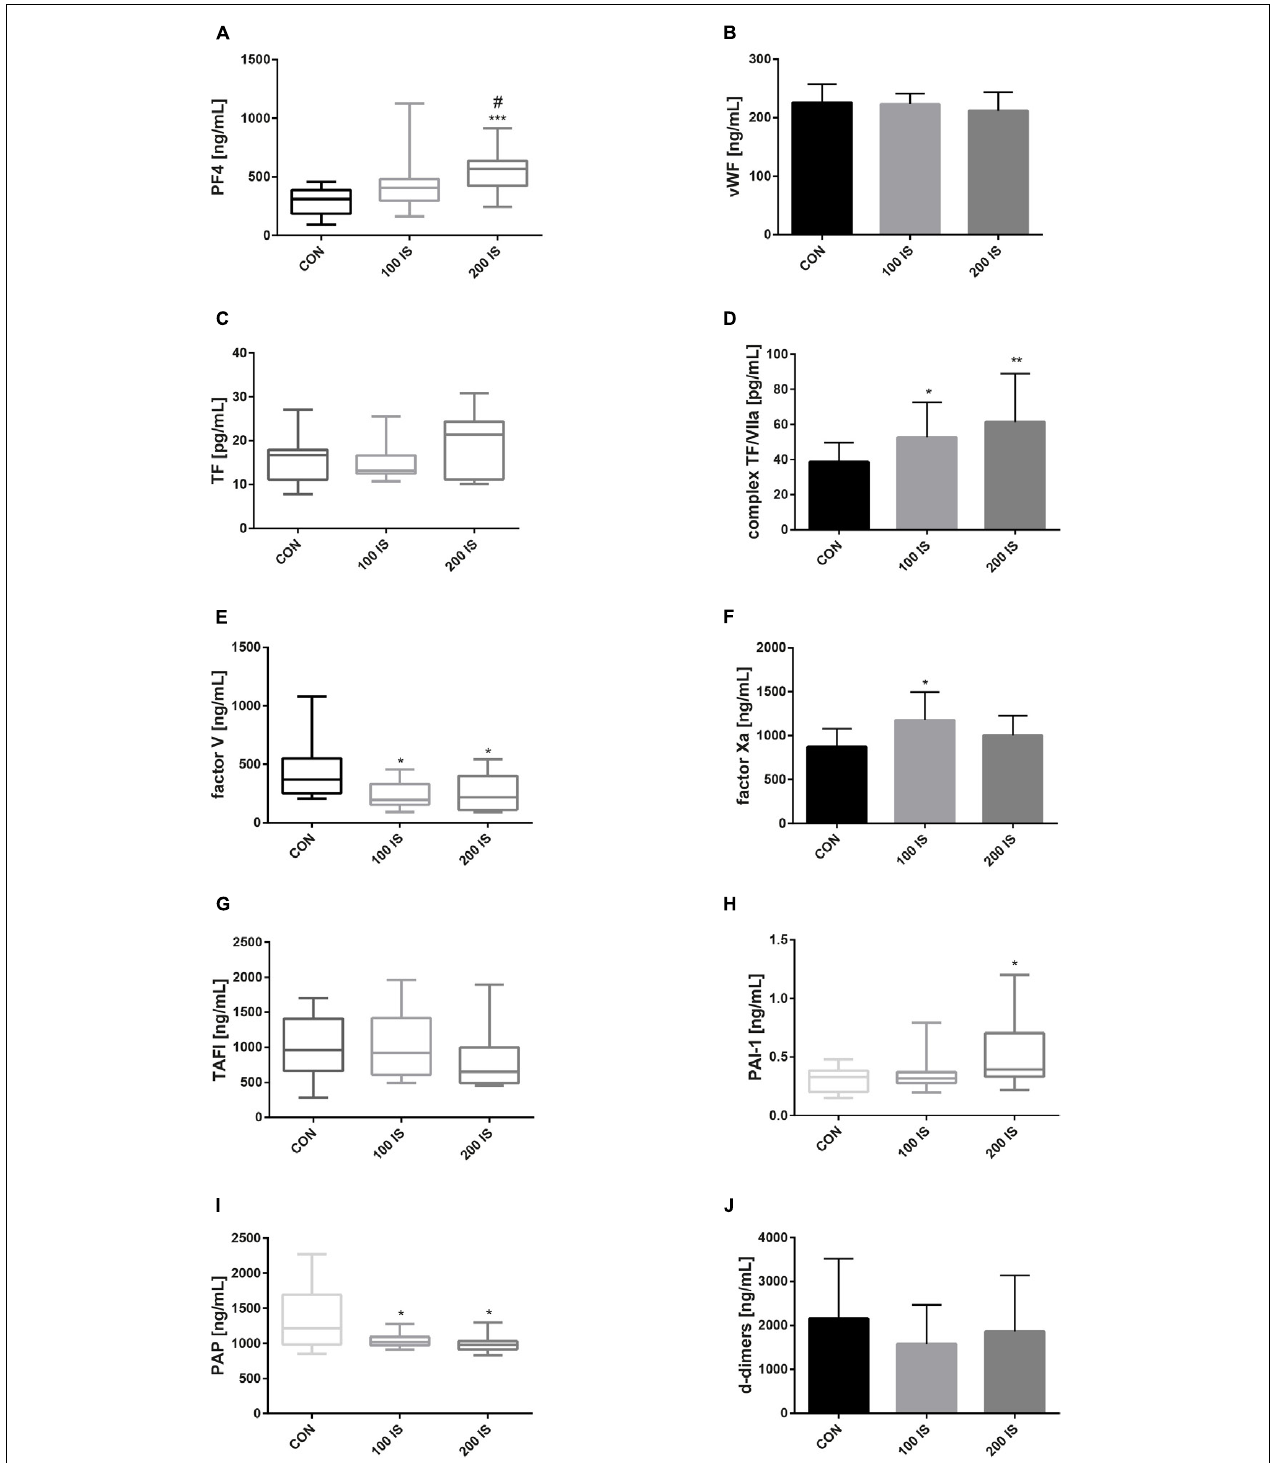
FIGURE 4 | IS-induced changes in hemostatic parameters: PF4 (A) , vWF (B) , TF (C) , TF/VII complex (D) , FV (E) , FXa (F) , TAFI (G) , PAI-1 (H) , PAP (I) , and d-dimers (J) . Data are presented as the mean ± SD or median (full range) depending on their distribution. CON, control group; 100 IS, group receiving IS in the dose of 100 mg/kg b.w./day; 200 IS, group receiving IS in the dose of 200 mg/kg b.w./day; IS, indoxyl sulfate; PF4, platelet factor 4; vWF, von Willebrand factor; FV, coagulation factor V; FXa, activated coagulation factor X; TF, tissue factor; TF/VII complex, TF/coagulation factor VII complex; TAFI, thrombin activatable fibrinolysis inhibitor; PAI-1, plasminogen activator inhibitor-1; PAP, plasmin-alpha2-antiplasmin complex; ∗ p < 0.05 compared to control; ∗∗ p < 0.01 compared to control; ∗∗∗ p < 0.001 compared to control; # p < 0.05 compared to 100 IS group.